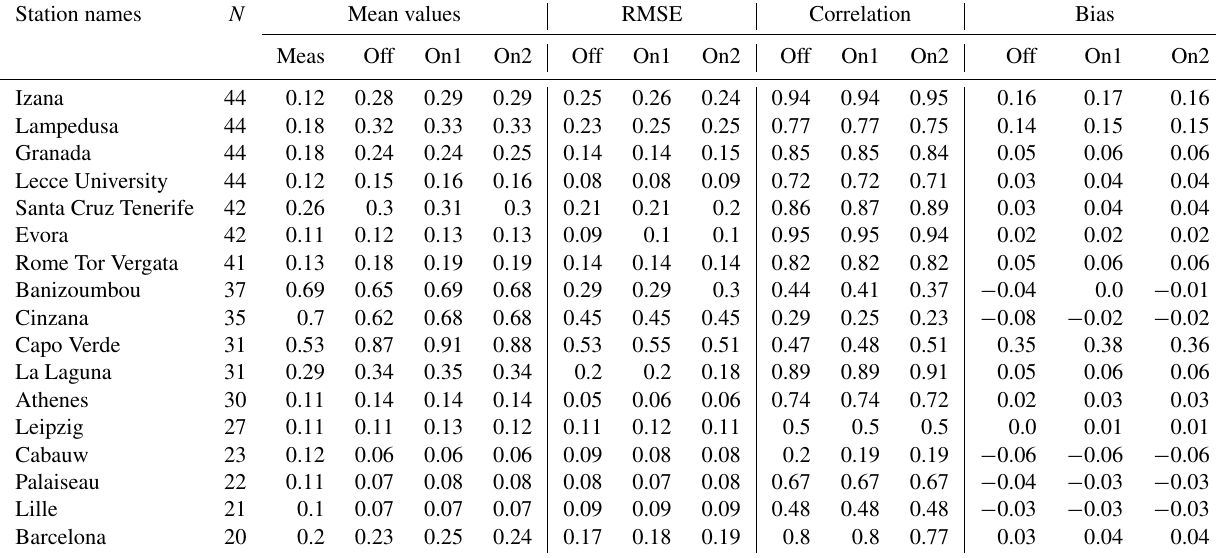
Table 1. Performance indicators of WRF-CHIMERE modelled values against daily AERONET AOD measurements over the period ranging from 1 June to 14 July. Meas, Off, On1 and On2 correspond to measurements, offline simulation, online case 1 simulation and online case 2 simulation, respectively. N is the number of observations and RMSE is the root mean square